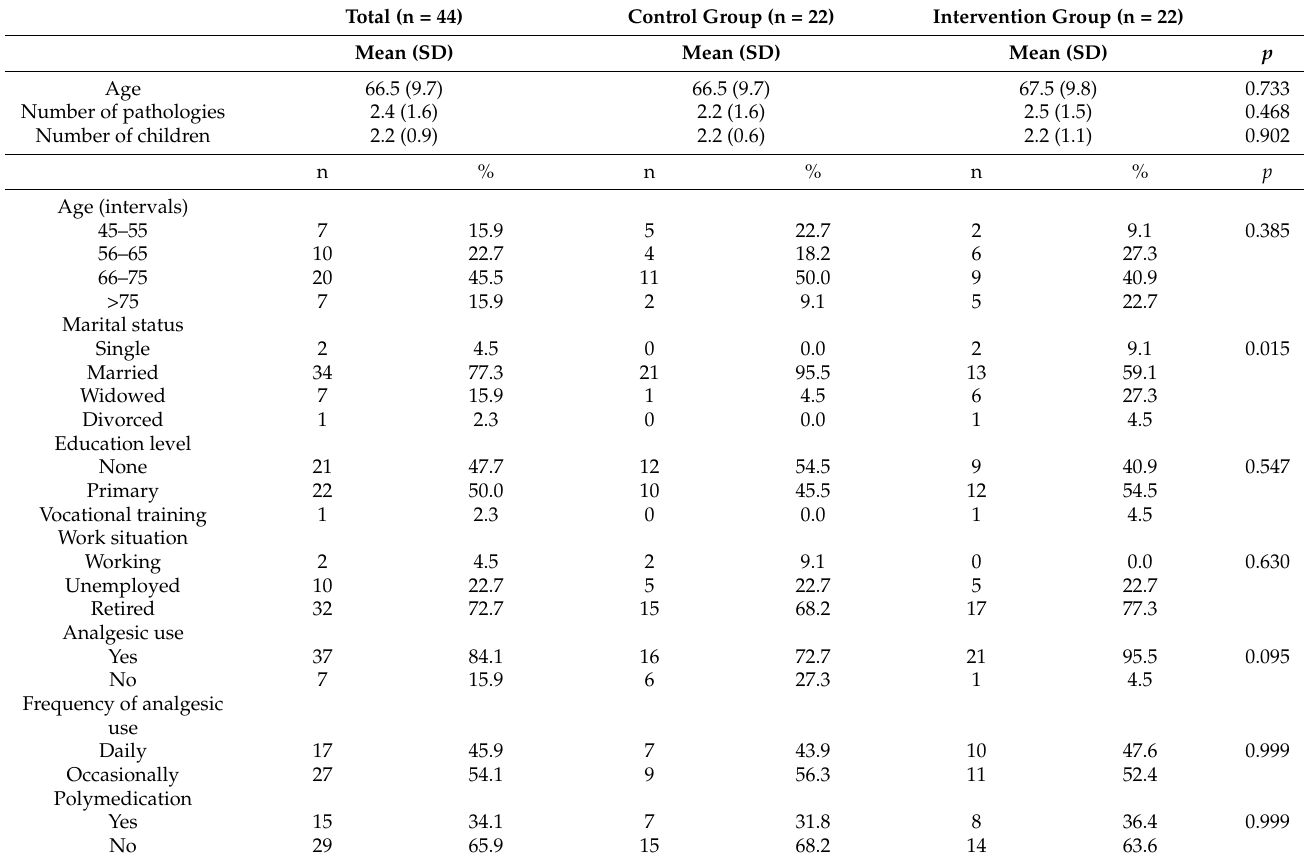
Table 1. Comparison of the sociodemographic and clinical characteristics of the sample. Total (n = 44) Control Group (n =